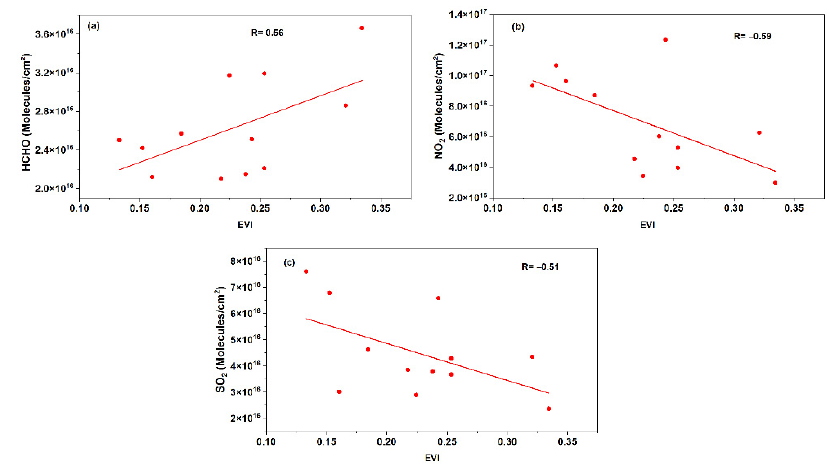
Figure 7. Relationship of monthly mean ( a ) HCHO, ( b ) NO 2 , and ( c ) SO 2 with monthly mean EVI.